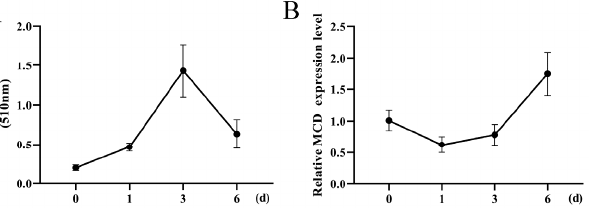
Figure 1. Phylogenetic tree based on MCD gene sequences of 7 representative animals constructed by MEGA 5 software. The number on the branch line represents the evolutionary branch length.